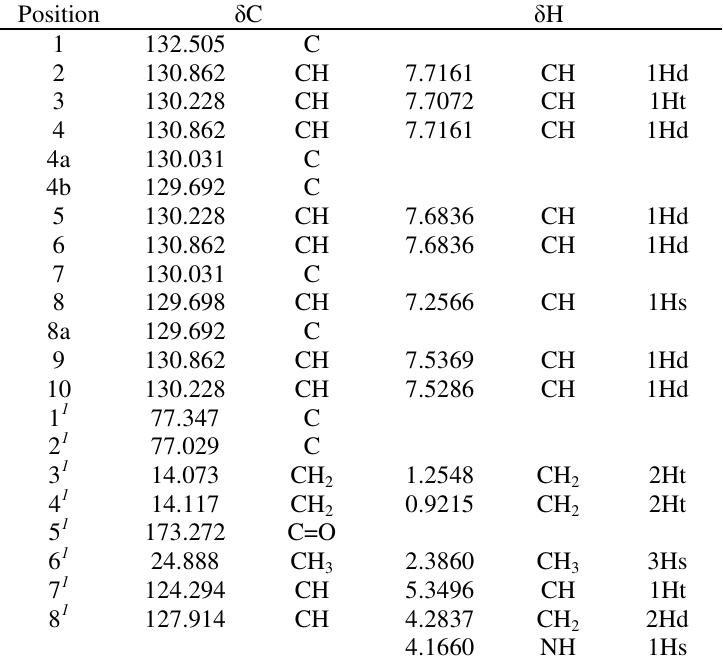
Table 1. 1 H (400 MHz) and 13 C NMR (75 MHz) of compound 3